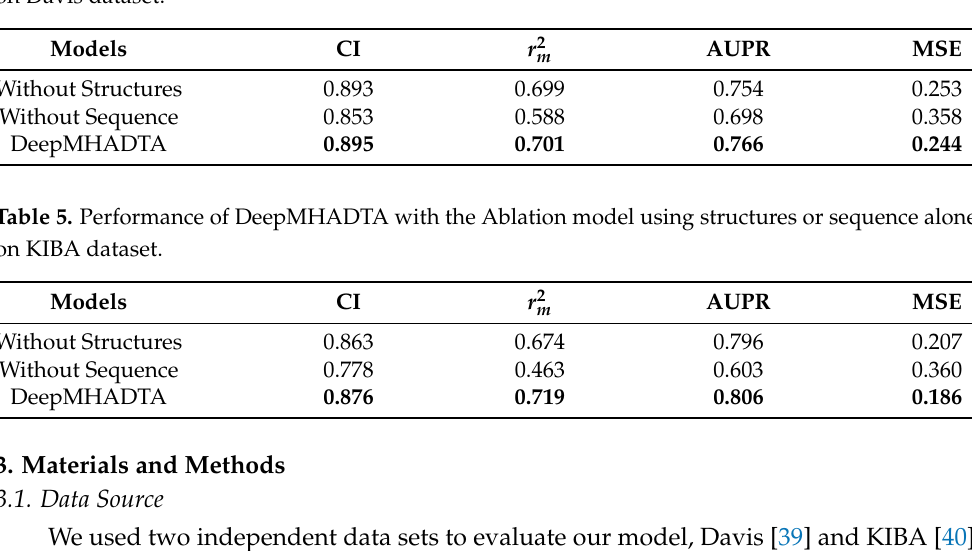
Table 4. Performance of DeepMHADTA and the ablation models using structures or sequence alone on Davis dataset.